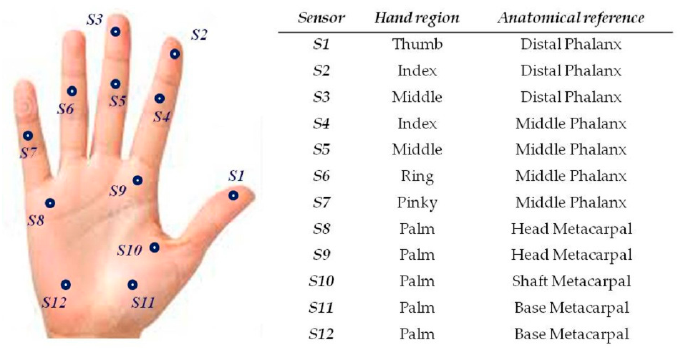
Figure 3. Sensor locations on the inner surface of the dominant or non-dominant hand .